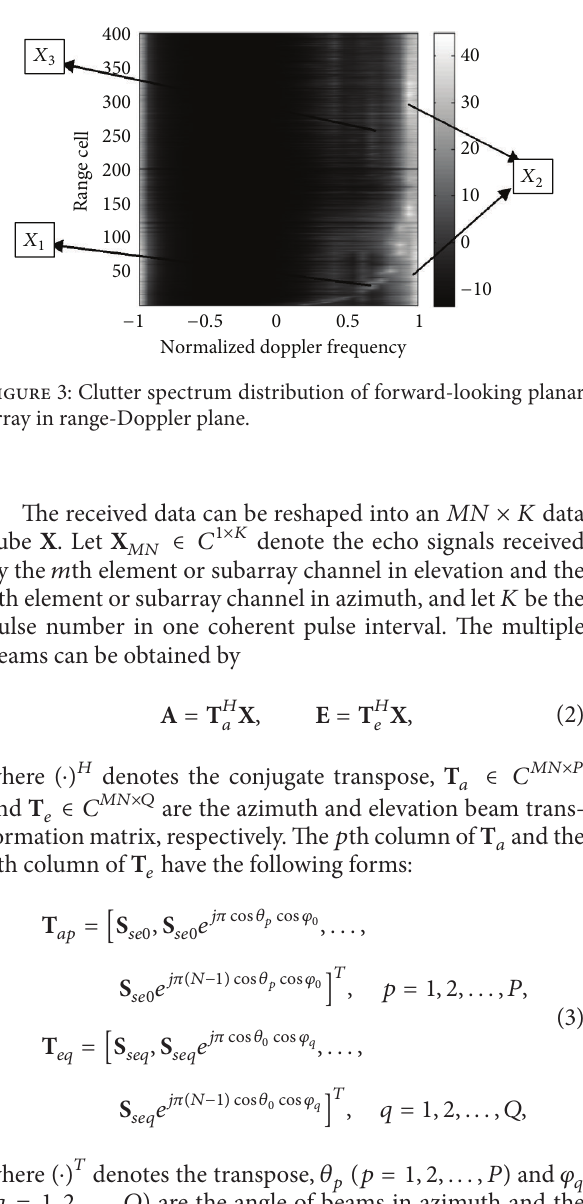
Figure 1: Geometry of non-SLAR.